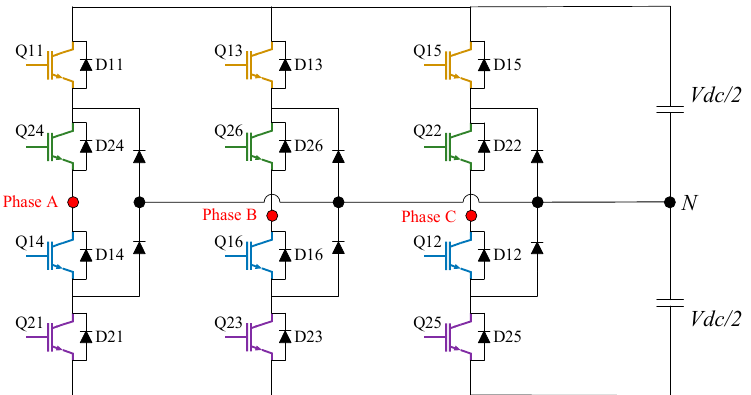
Figure 6. Three-phase three-level NPC VSC converter.